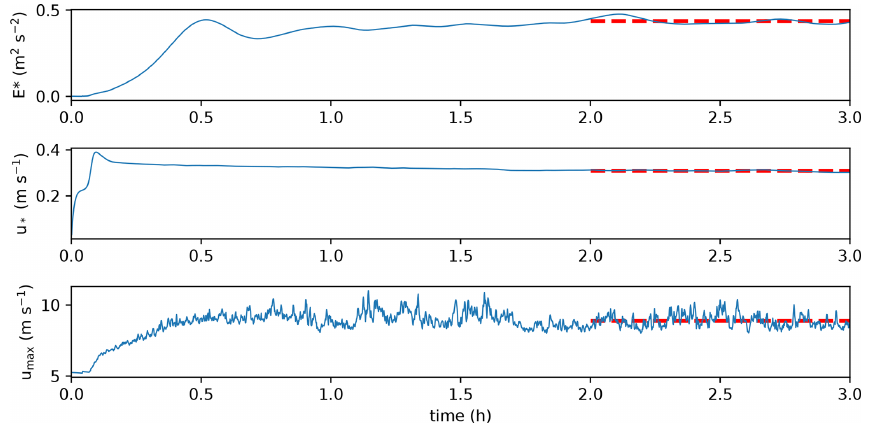
Figure 1. Simulation case 1: time series of resolved-scale turbulence kinetic energy ( E ∗ ), friction velocity ( u ∗ ) and maximum velocity of the u component ( u max ). All quantities are averaged over the entire 3-D domain. The dashed red lines indicate the respective mean value between 2 and 3h of simulated time.